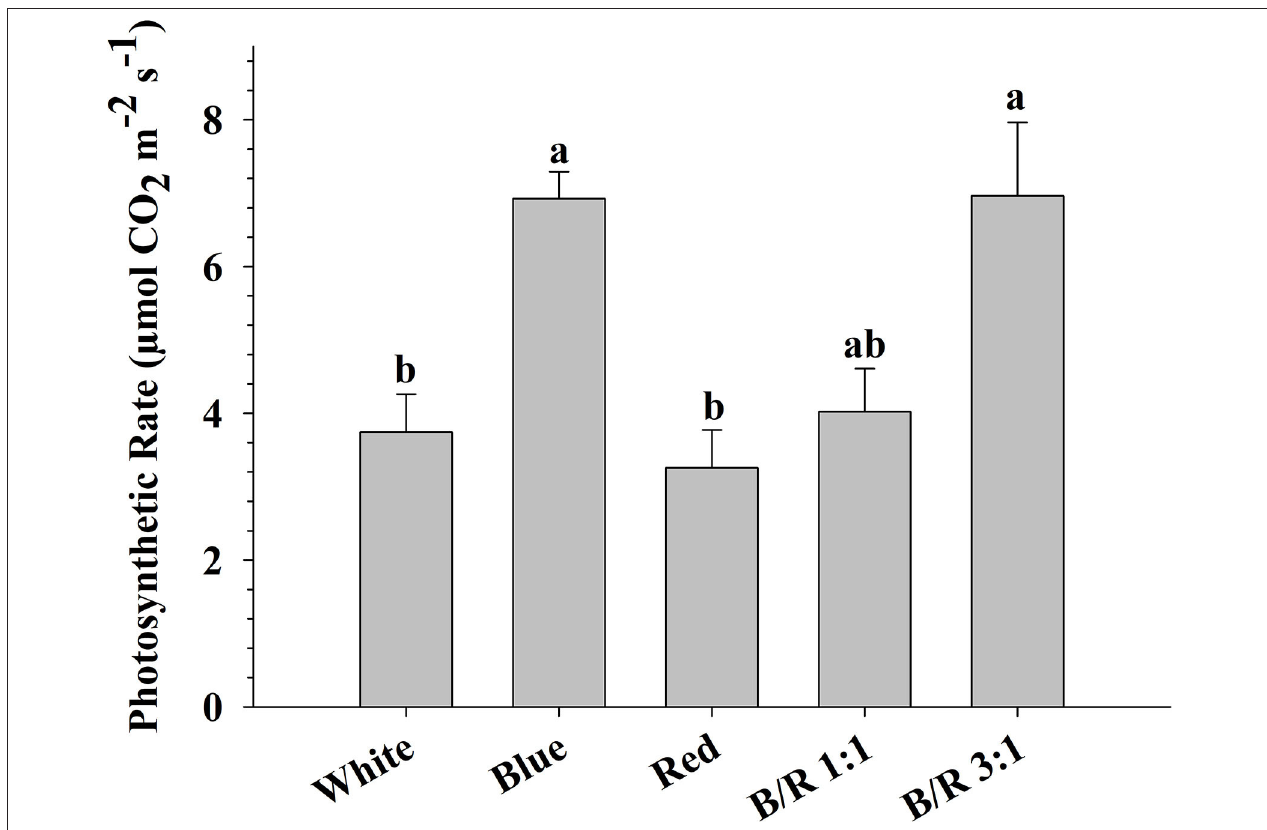
FIGURE 5 | Photosynthetic rate ( µ mol CO 2 m − 2 s − 1 ) of Brosimum gaudichaudii seedlings grown in vitro under different LED spectra for 50 days. Means followed by the same letter do not differ according to Tukey’s test at 5% probability. The values are presented as the mean ± standard error ( n = 5).